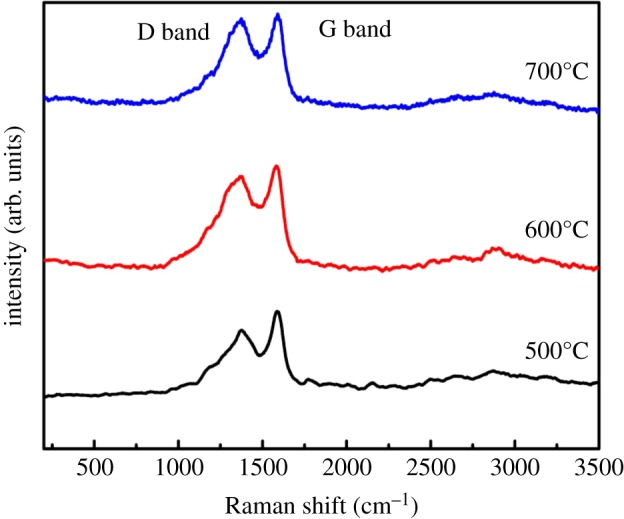
Raman spectra of Cu2O/HCFs. Those were prepared at 400, 500 and 600°C for Cu2O/HCFs.